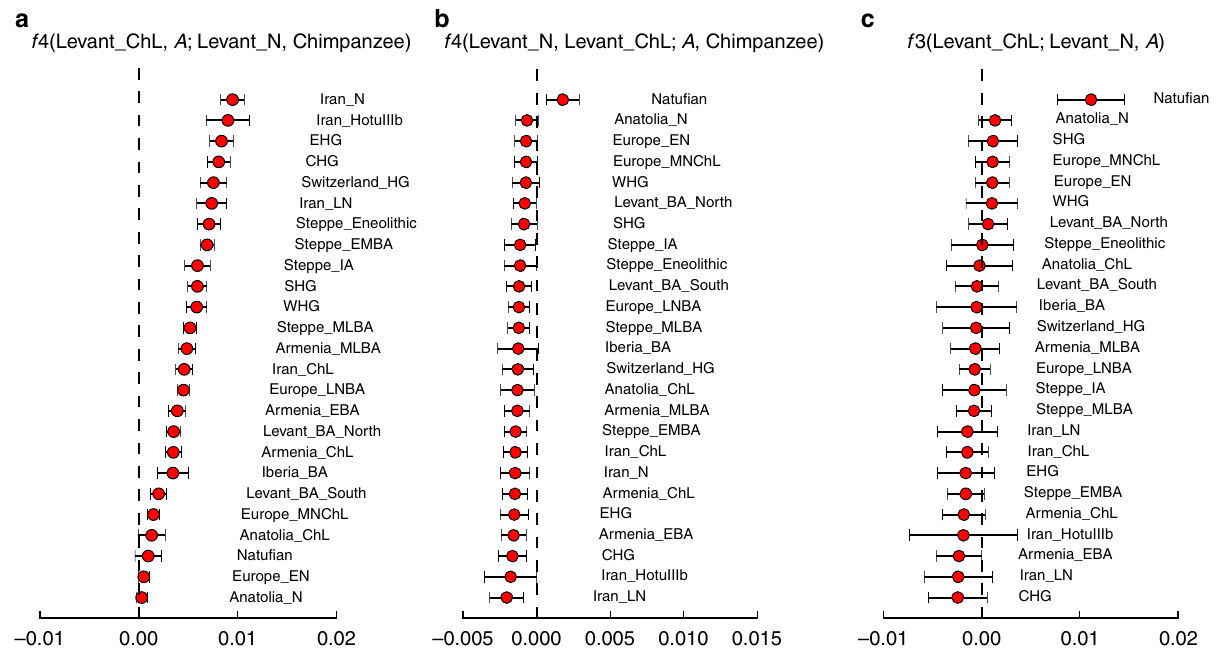
Fig. 4 Genetic characteristics of the Levant_ChL. a The statistic f 4 (Levant_ChL, A; Levant_N, Chimpanzee) demonstrates a close relationship between the Neolithic and Chalcolithic Levant populations, as the Levant Neolithic shares more alleles with the Levant Chalcolithic than with any other populations. b The statistic f 4 (Levant_N, Levant_ChL; A, Chimpanzee) shows an asymmetrical relationship between Levant_N and Levant_ChL and other ancient West Eurasian populations. The statistic is most negative for populations from Iran and the Caucasus, indicating that Levant_ChL shares more alleles with them than does Levant_N. c The statistic f 3 (Levant_ChL; Levant_N, A) tests for signals of admixture in Levant_ChL. Negative f 3 -statistics indicate that the Levant_ChL population is admixed. Populations from Iran and the Caucasus produce the most negative statistics. The estimated statistic ± 3 standard errors is